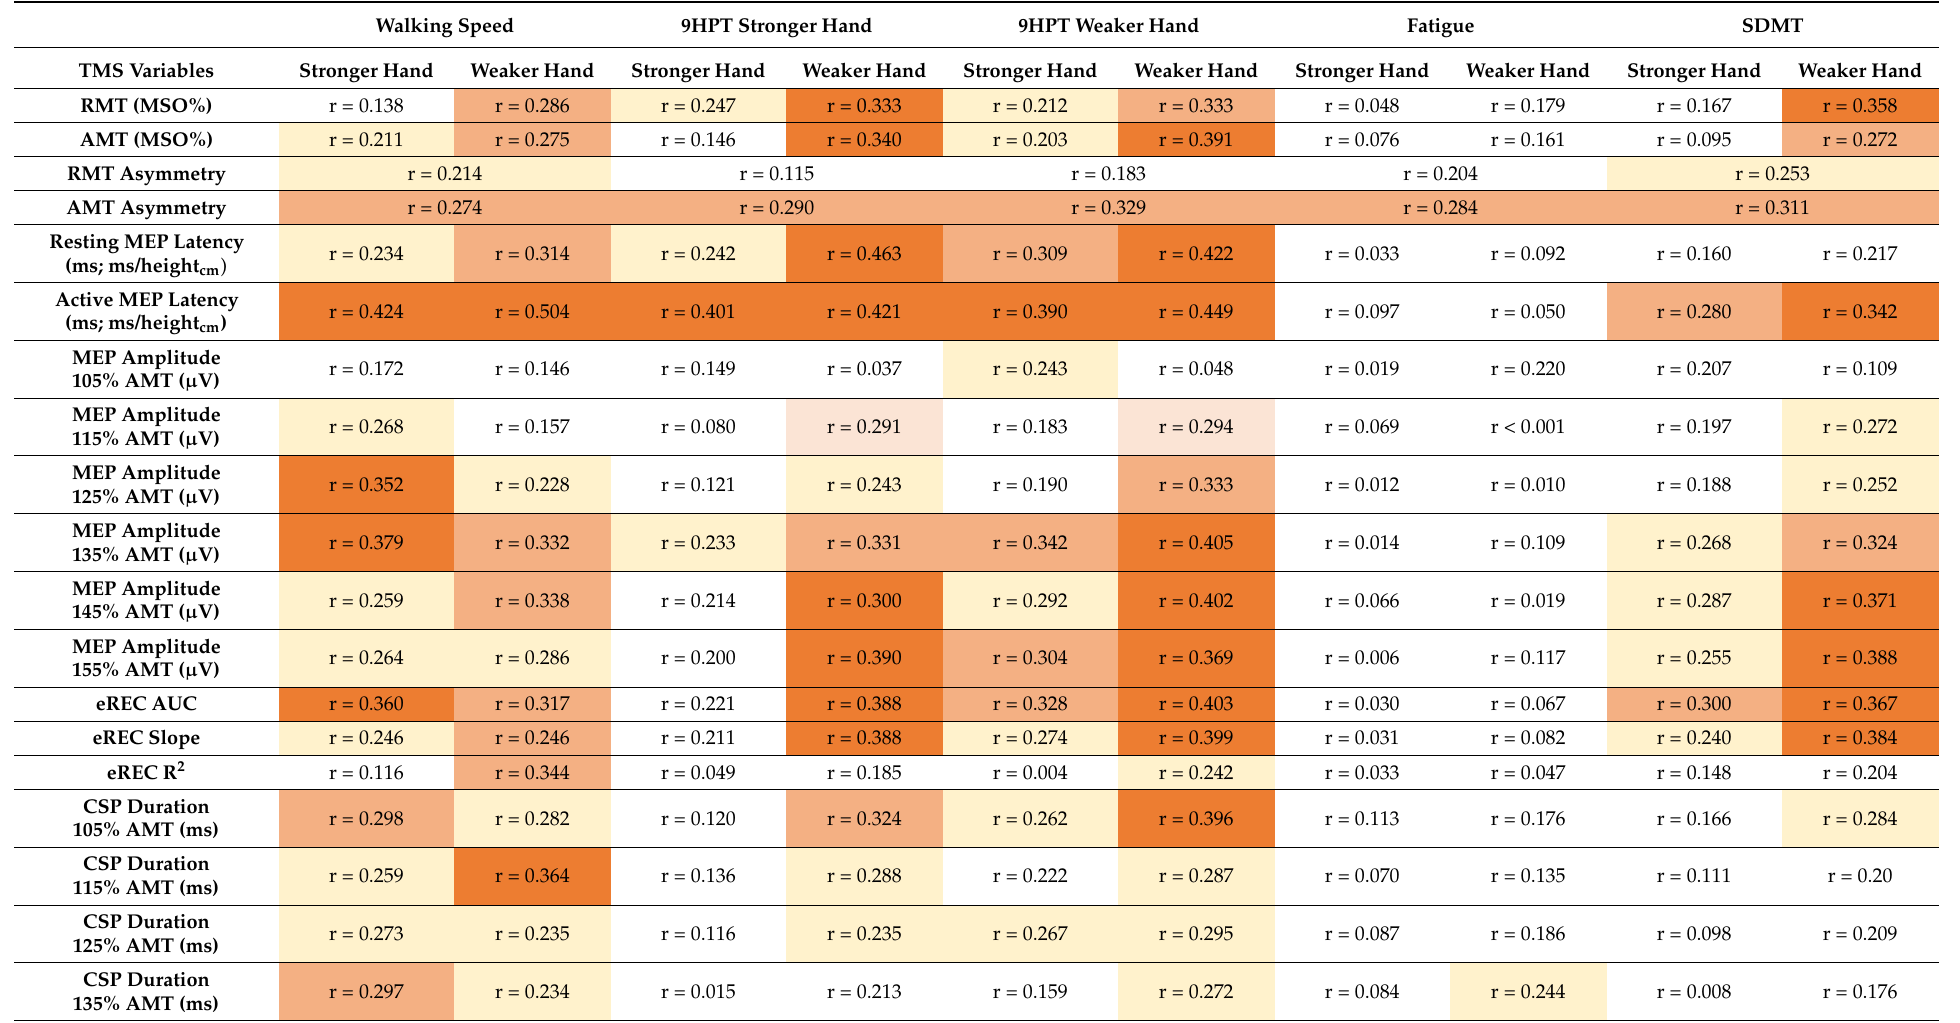
Table 3. Identifying significant relationships (bivariate) between the transcranial magnetic stimulation variables and clinical outcomes (absolute # r-value, and p -value). Walking Speed 9HPT Stronger Hand 9HPT Weaker Hand Fatigue SDMT TMS Variables Stronger Hand Weaker Hand Stronger Hand Weaker Hand Stronger Hand Weaker Hand Stronger Hand Weaker Hand Stronger Hand Weaker